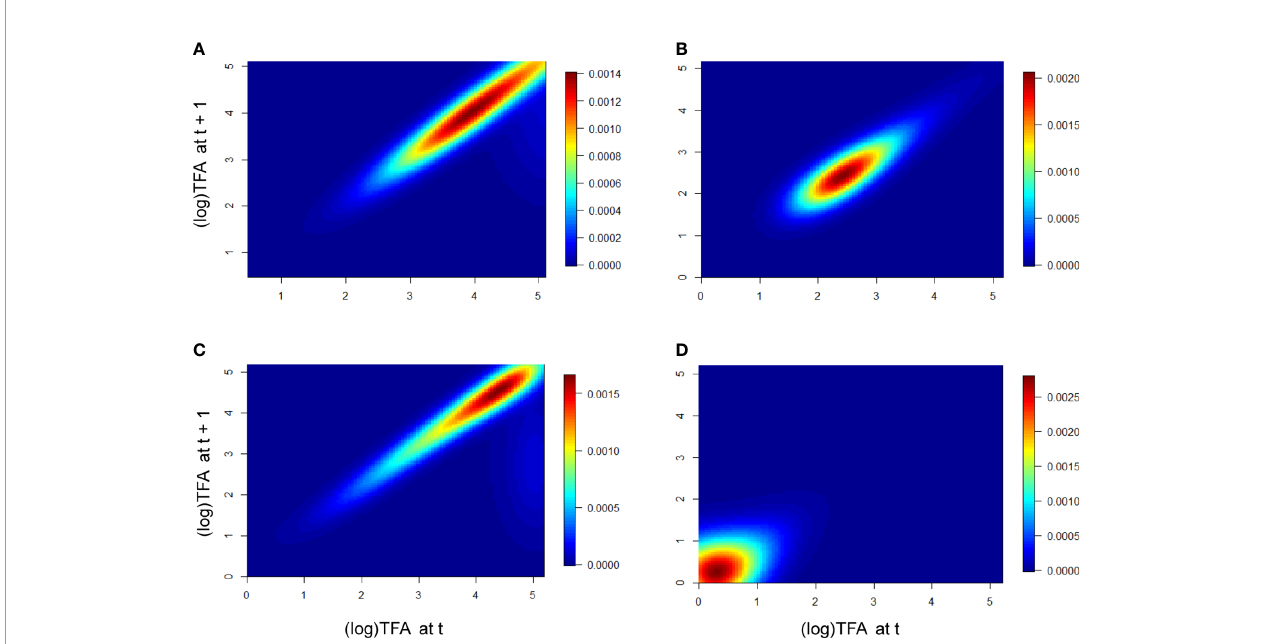
FIGURE 3 | Elasticity of the populations Cuanajo and Icuacato. Cuanajo (A) fi rst period, (B) second period. Icuacato (C) fi rst period, (D) second period (wild fi re). Warmer colors represent size stages that mostly contributed to l